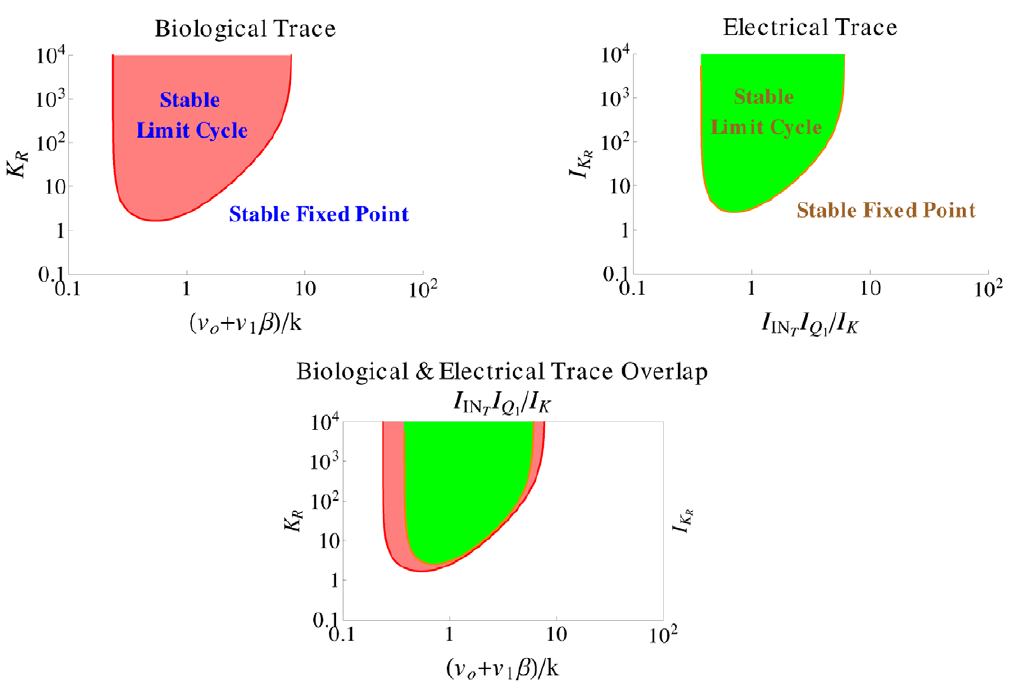
I Q = I K has been plotted in complete analogy to [1]. The and I IN R T 1